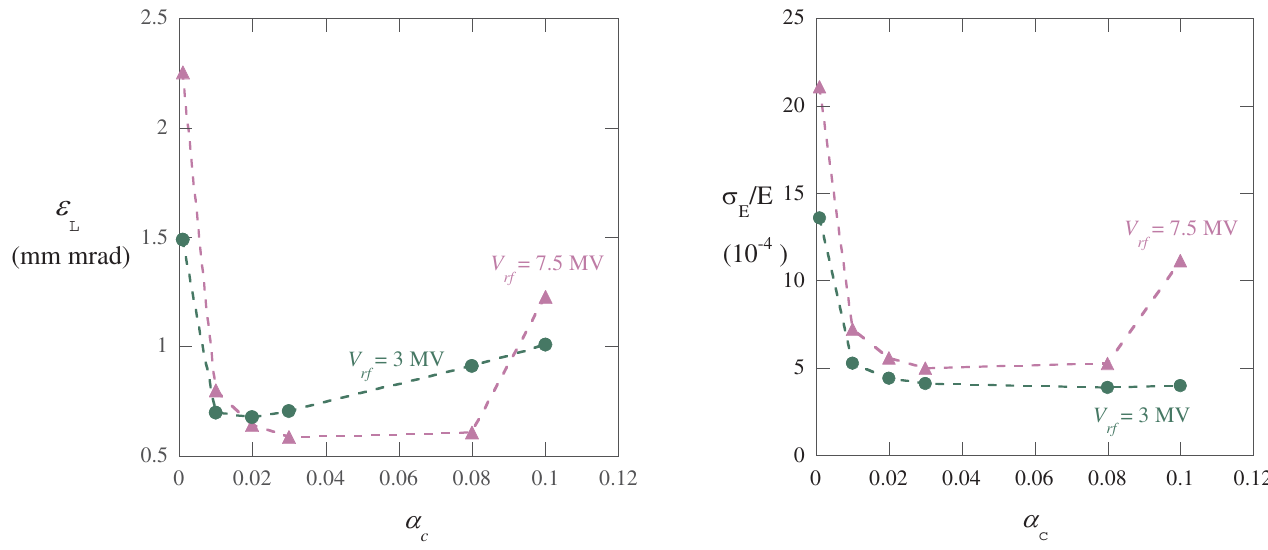
. Dots correspond to rf